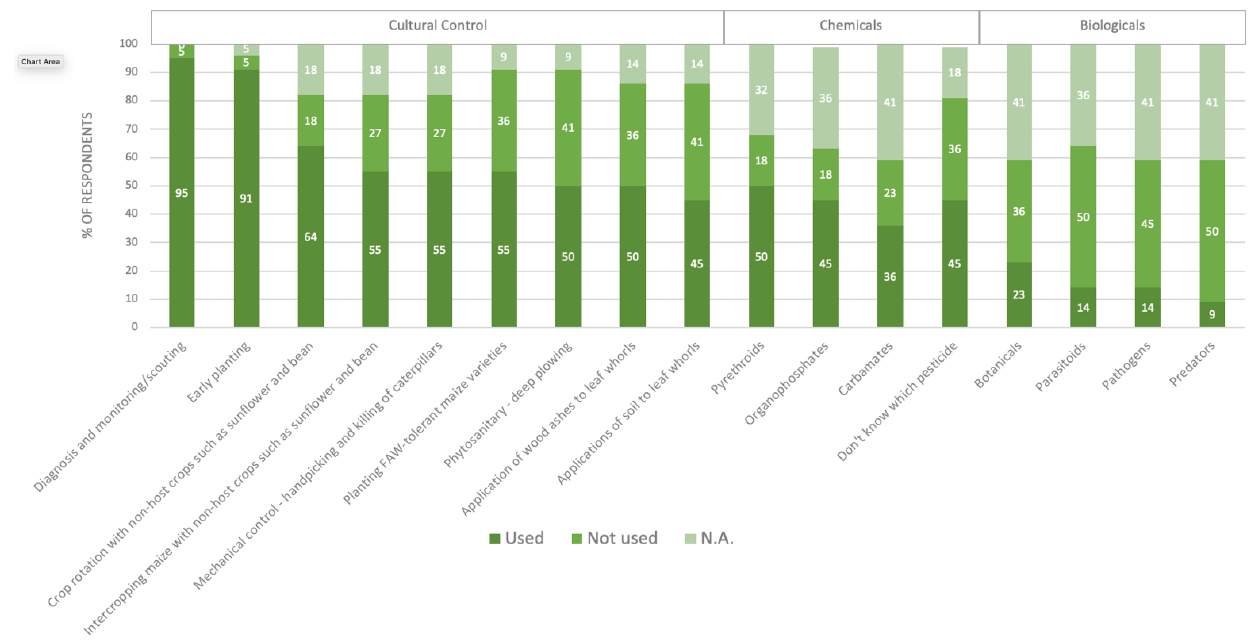
Figure 3. Percentages of respondents reporting different methods for FAW control in cereal crops. Respondents who did not answer the question were reported as N.A.